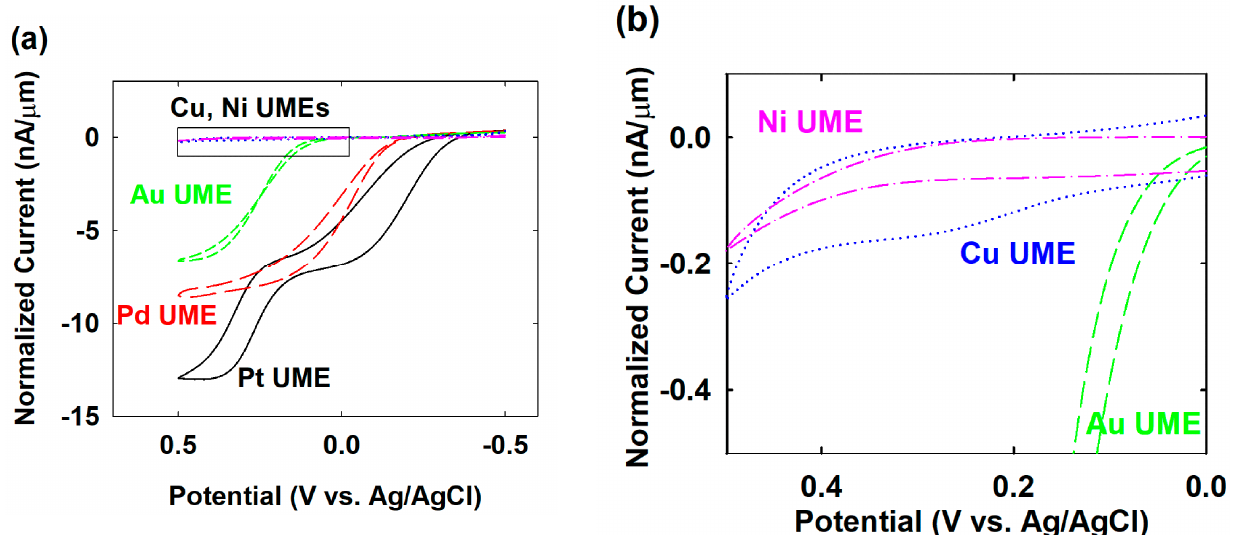
Figure 2. ( a ) Cyclic voltammograms of hydrazine oxidation on Pd (red long-dashed, diameter 20 µ m), Pt (black solid, diameter 25 µ m), Au (green dashed, diameter 25 µ m), Ni (pink dash-dotted, diameter 25 µ m), and Cu (blue dotted, diameter 15 µ m) UME in a 50 mM phosphate buffer (pH 6.8) containing 15 mM hydrazine. Currents are normalized for the radius of each UME. ( b ) Zoomed-in insert of ( a ).